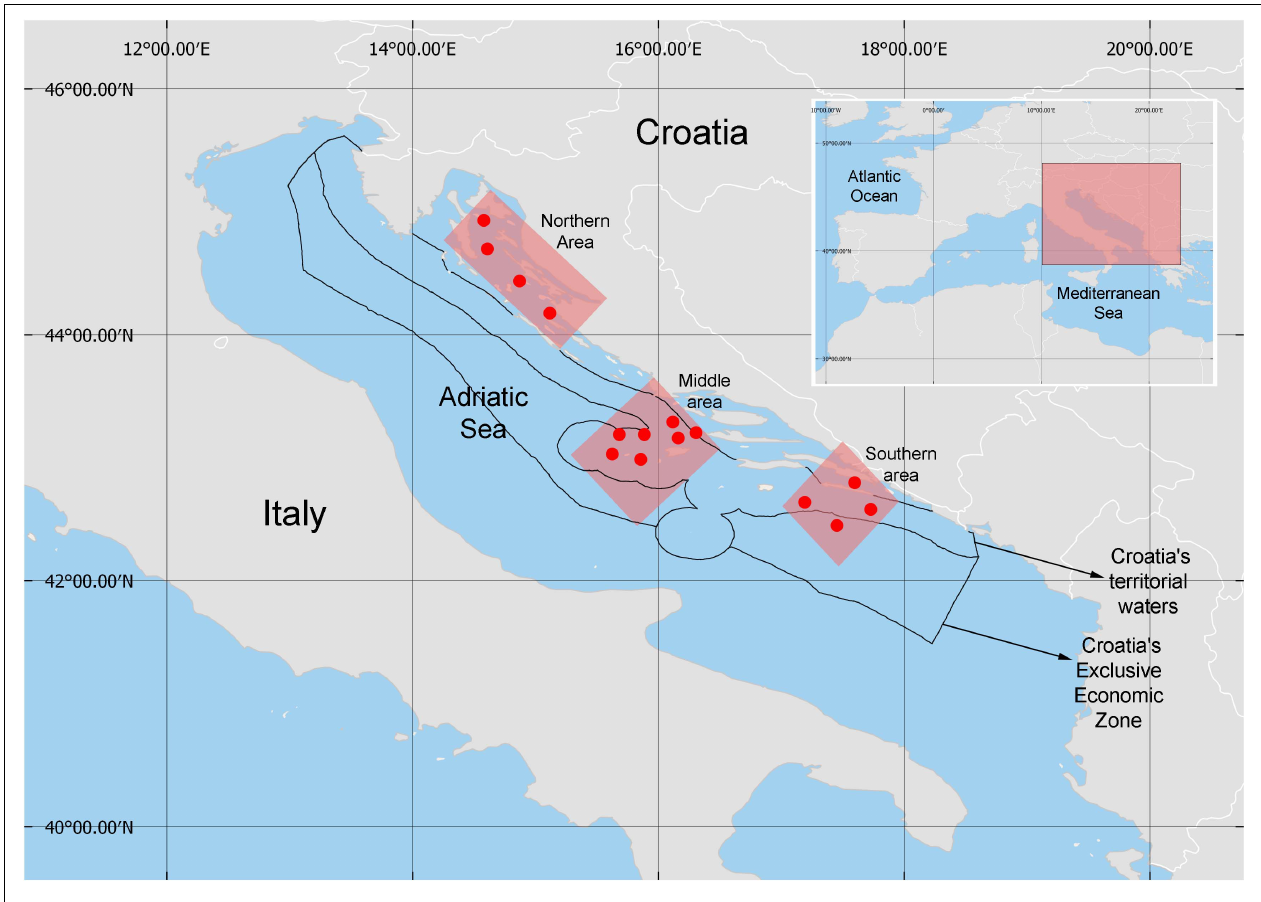
FIGURE 1 | Sites sampled in the Northern, Middle and Southern areas located within the Croatian fishing grounds of the Adriatic